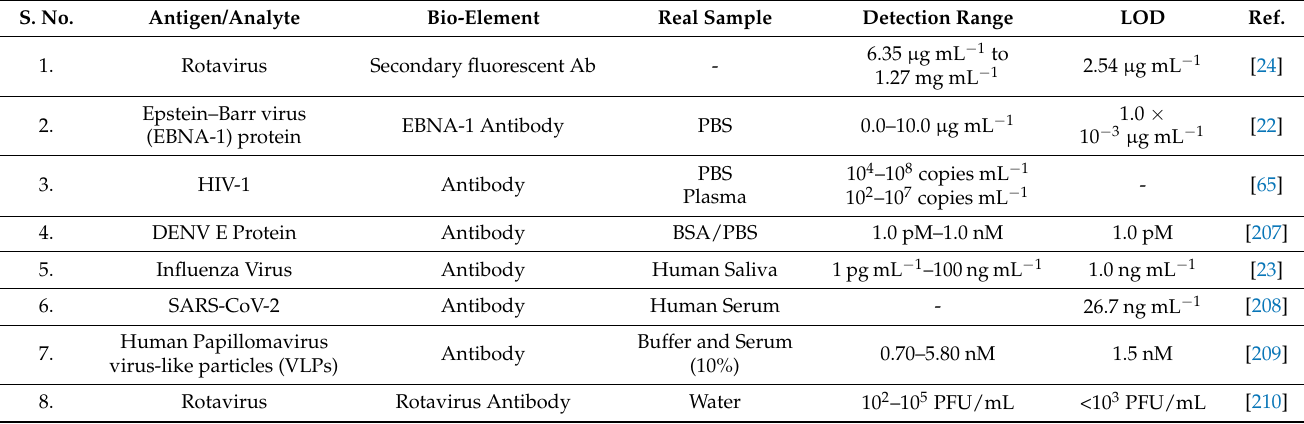
Table 4. Photonic technique-based sensing platform for viral